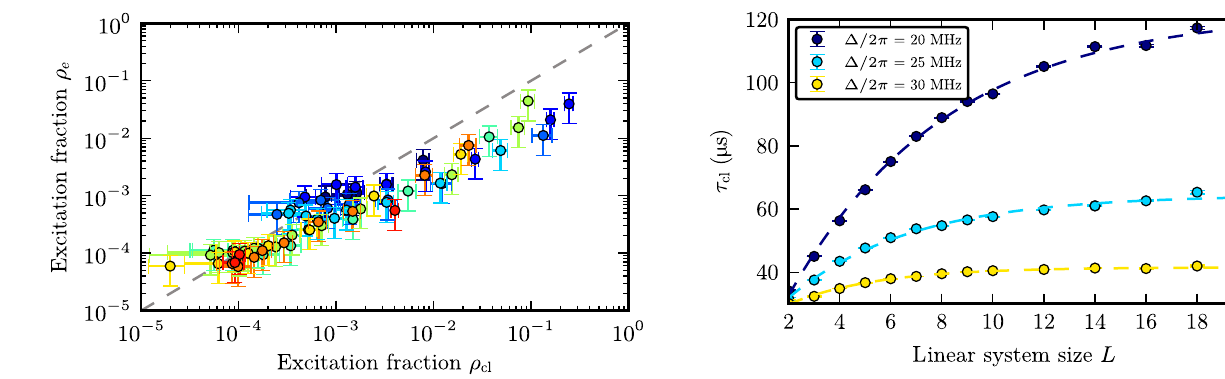
FIG. 6. Finite-size extrapolation of the cluster lifetime τ 5. Comparison between the mean excitation fraction ρ e Rabi frequency Ω ¼ 2 π × 160 kHz and different detuning Δ . t Þ and the extracted from the maximal detected ion rate R ion ð The dashed lines indicate an exponential saturation fit of about ¯ m=N N excitation fraction ρ calculated using the effective cl ¼ cl at ½ 1 − c exp ð − L=L 0 Þ(cid:2) withaconstant c .Here,thecharacteristiclength cluster model. The color code corresponds to the same Rabi scale L 0 ¼ 6 . 2 ; 3 . 2 , and 2.1 is comparable to the cluster size ¯ m frequencies as in Fig. 3. The gray dashed line is a linear curve with a slope of